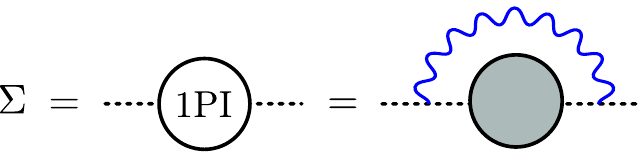
Figure 8 . The planar fermion self energy Σ( p ) satisfies a simple Schwinger-Dyson